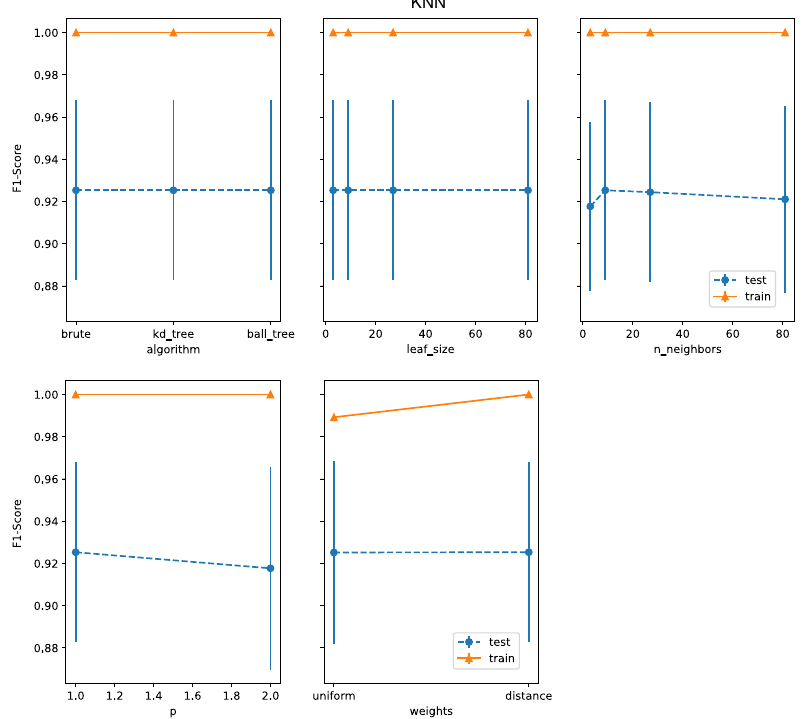
Figure 7. Mean performance of KNN models for respective evaluated hyperparameters with standard